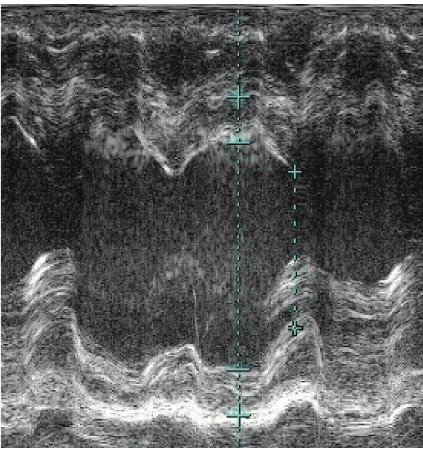
Figure 3: Echocardiography shows preserved left ventricular ejec- tion fraction of 58% without regional wall motion